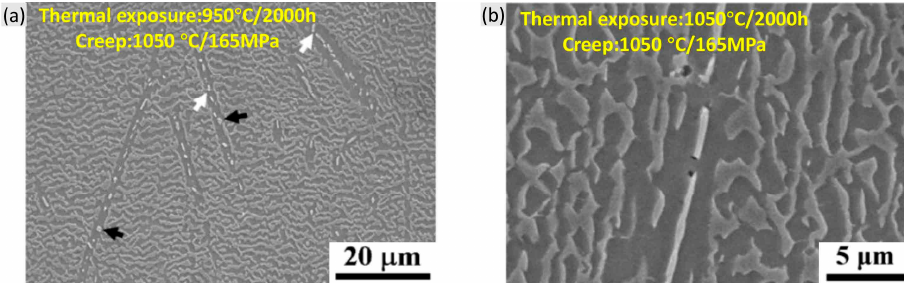
Figure 20. Microstructures in the crept specimens of CMSX-4 alloy after thermal exposure showing ( a ) rotated (white arrow) and coarsened (black arrow) µ particles free of crack and ( b ) crack initiation from the needle-like µ particle but without propagation [62].